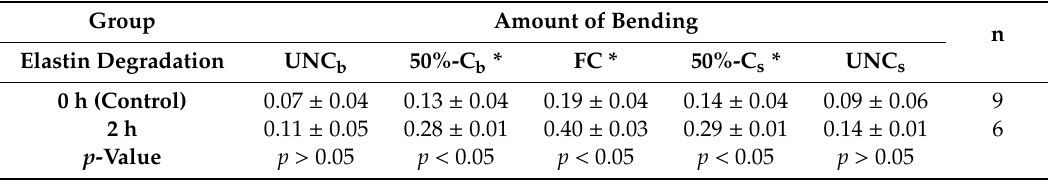
Table 2. Mean ± standard error of the mean (SEM) of bending of samples of mean curvature, k mean (1/mm) at five levels of bending for the un-degraded and elastin-degraded porcine aortic valve leaflet specimens after 2 hours of elastase exposure (n = 6 – 9 samples/group). UNC b , 50%-C b , stands for unconstrained and semi-constrained during leaflet strip bending, while UNC s and 50%-C s refer to these events during specimen straightening; FC stands for the leaflet strip at the fully constrained or fully-flexed state.